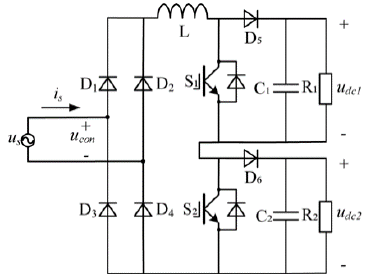
Figure 2. Single-phase diode H-bridge two-stage cascaded boost rectifier for transformer-less cascaded multilevel converter (TCMC).